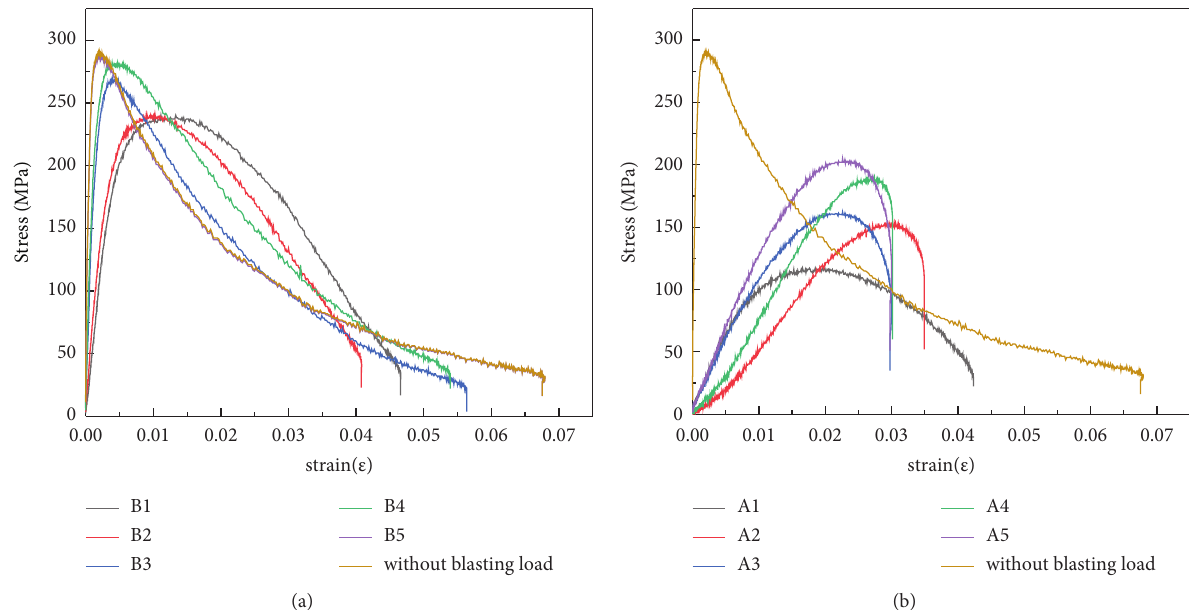
Figure 5: Stress-strain relationship curves of the core sample in the directions. (a) Perpendicular to the slit. (b) Parallel to the